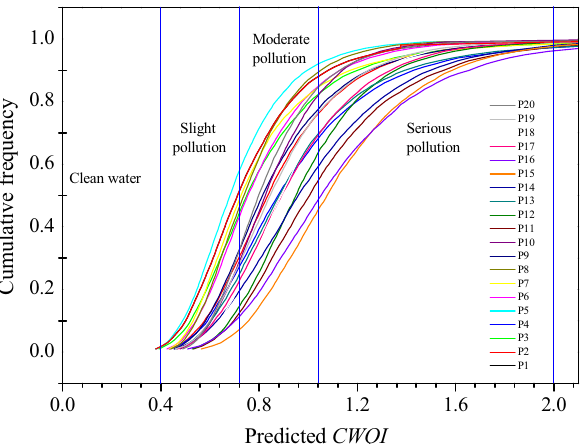
Figure 4. Cumulative probability curve of the CWQI for the different sampling locations in the East Tiaoxi River.